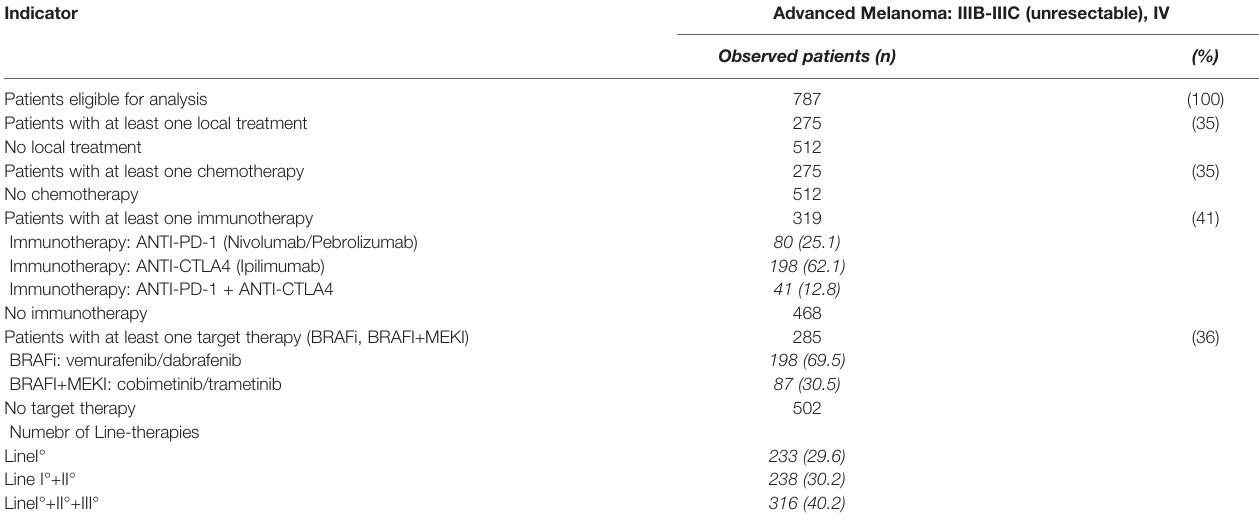
TABLE 2 | Distribution of therapies and combined therapies in the cohort of advanced melanoma patients.